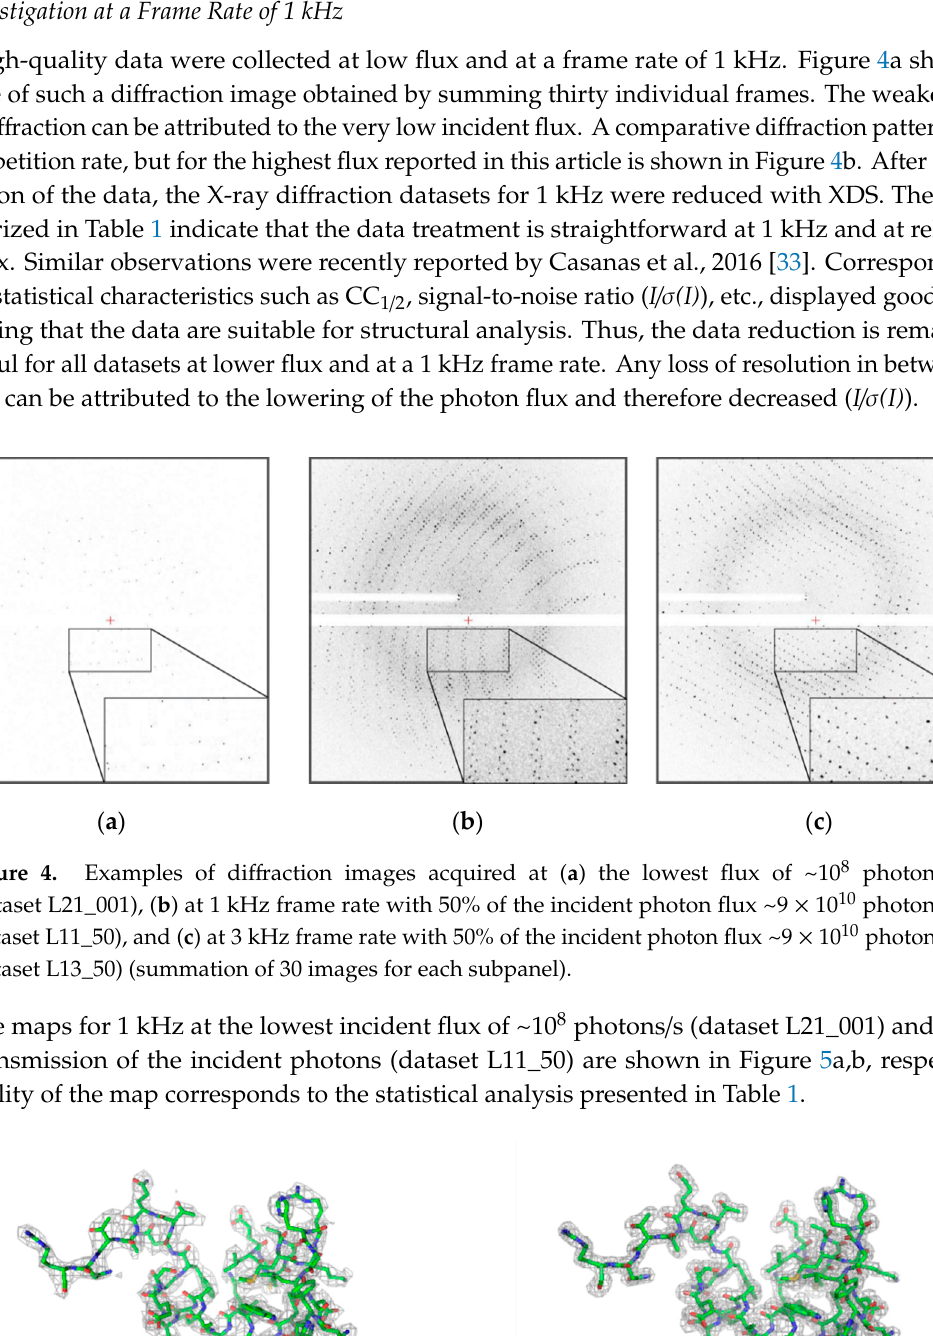
Figure 3. Radial average of the X-ray diffraction intensities determined at 1 kHz operational frequency of frame readout of the Eiger X 1M detector for different transmissions and in the lack of protein crystals, i.e., the background coming from the air scattering and other factors. Y-axis gives the radial average of photons counted by the detector per 1 ms exposure time per frame. The average is calculated for one typical background frame.